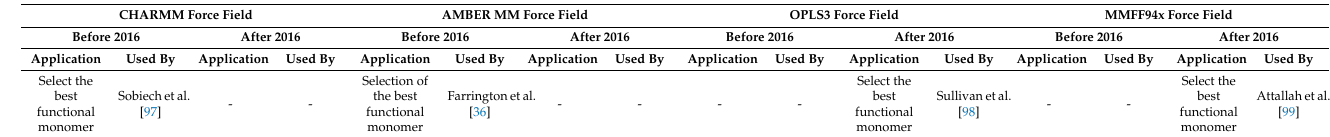
Table 7. Comparison of the molecular mechanics approach to design molecularly imprinted polymers (MIPs) before and after 2016.